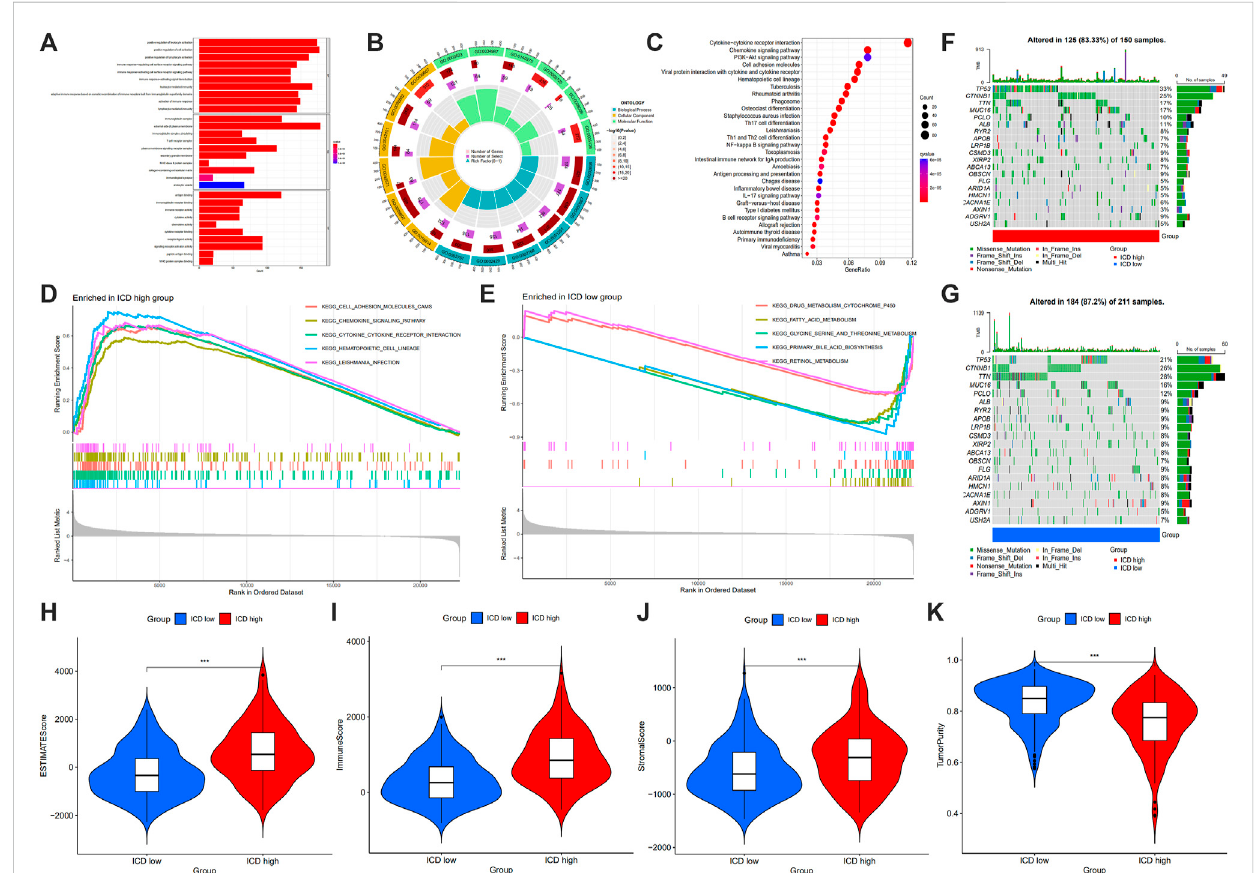
FIGURE 5 GO term (A,B) and KEGG pathway (C) analysis of DEGs between ICD high and low expression groups, and GSEA analysis (D,E) , maftools (F,G) , ESTIMATE score (H) , immune score (I) , stromal score (J) and tumor purity (K) in ICD high and ICD low group. (GO: Gene Ontology, KEGG: